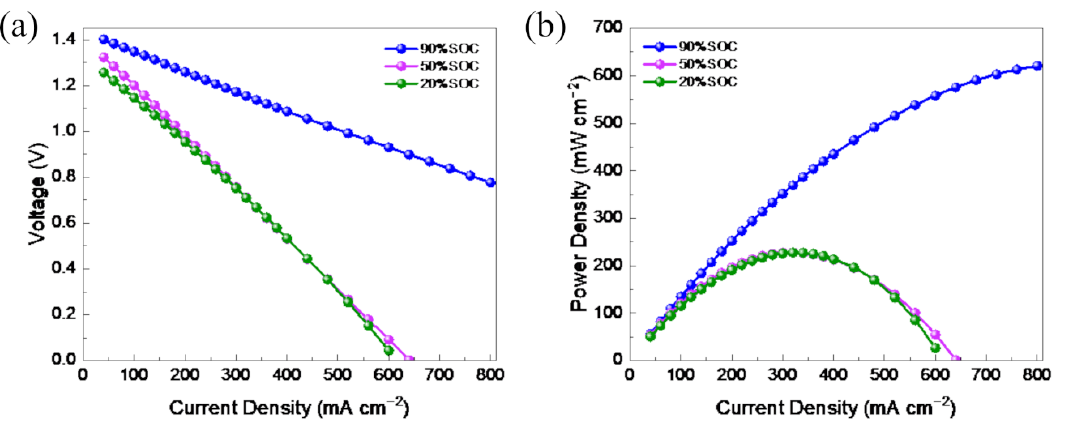
Figure 10. The ( a ) polarization curve and ( b ) power density of a VFB with M3-300